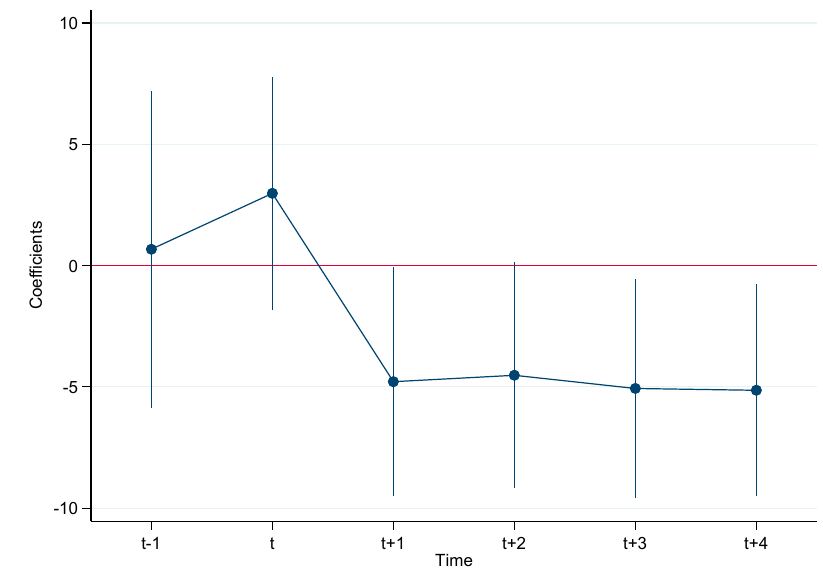
Figure 2. Parallel trend test ( AQI ).